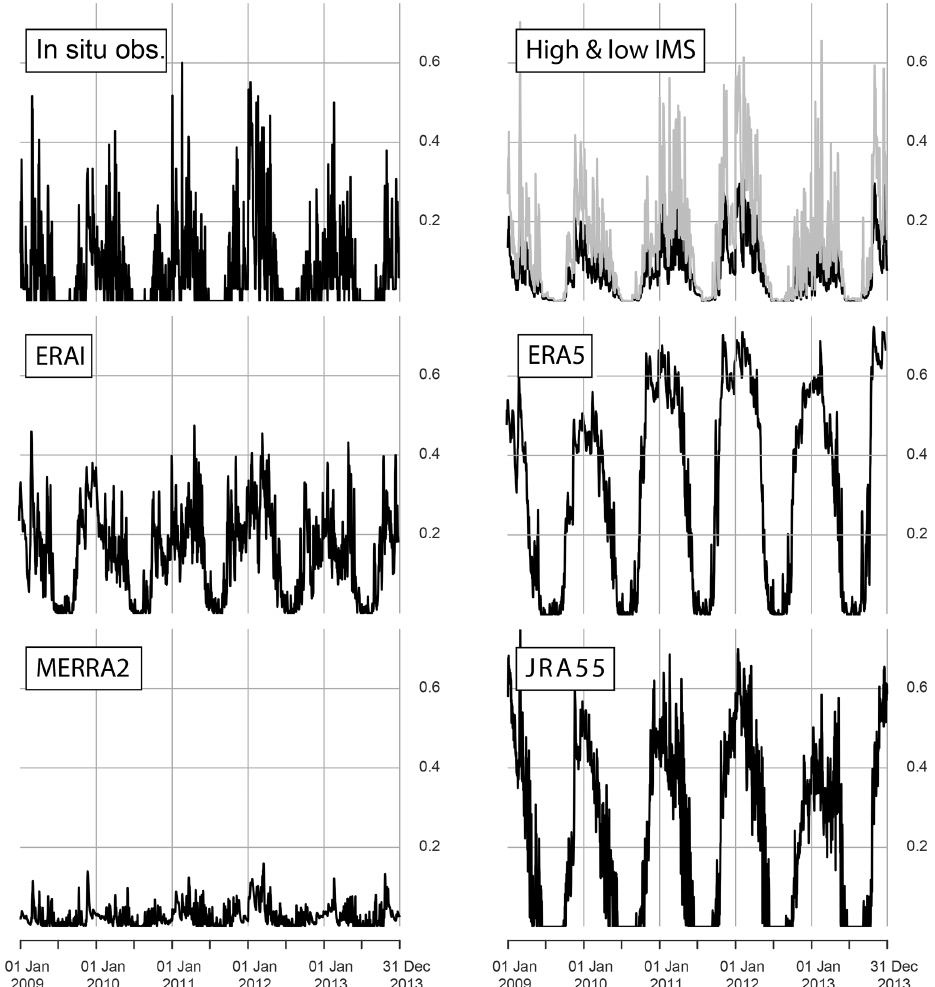
Figure 3. Comparison of daily SCF (between 0 and 1) over the 5-year period 2009–2013 between the observations, comprising both the in situ station and IMS satellite data, with the four reanalyses collocated at the station coordinates, namely ERA5, ERA-I, MERRA-2 and JRA-55. The data have been averaged over the 33 stations. The IMS data are represented by the low and high estimates, resulting from converting the binary 4km data to a grid comparable to the resolution of the